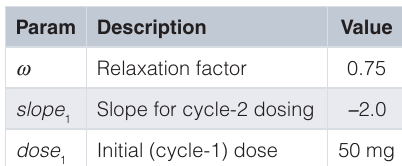
Table 3. Values of the tuning parameters of the dose titration algorithm simulated in Figure 5.